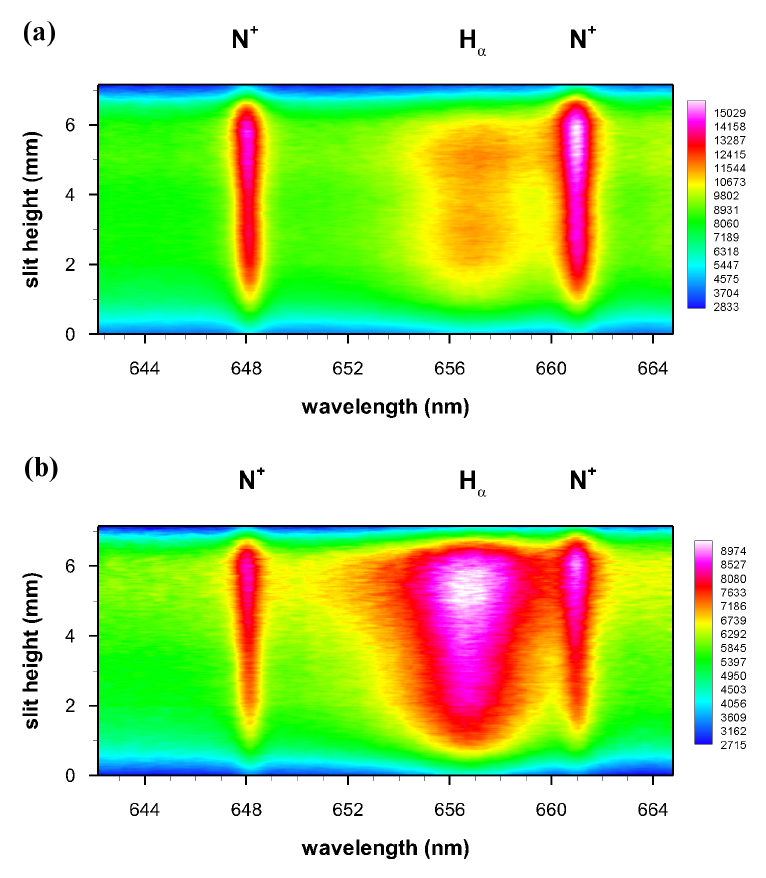
Figure 8. Time delay of: ( a ) 300 ns; and ( b ) 400 ns. The N + lines allow one to determine electron density and evaluate H β self-absorption. Reproduced from Ref. [31] with